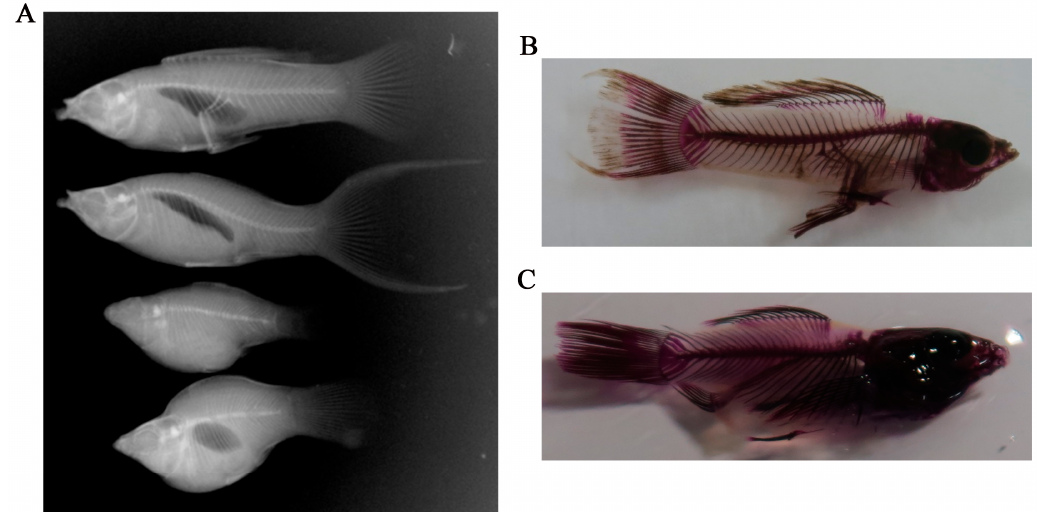
Figure 2. Skeletons of the normal molly and the dwarf molly. ( A ) Skeletons of normal and dwarf mollies under X-ray radioscopy; ( B ) skeleton of a normal molly using skeletal staining; ( C ) skeleton of a dwarf molly using skeletal staining.